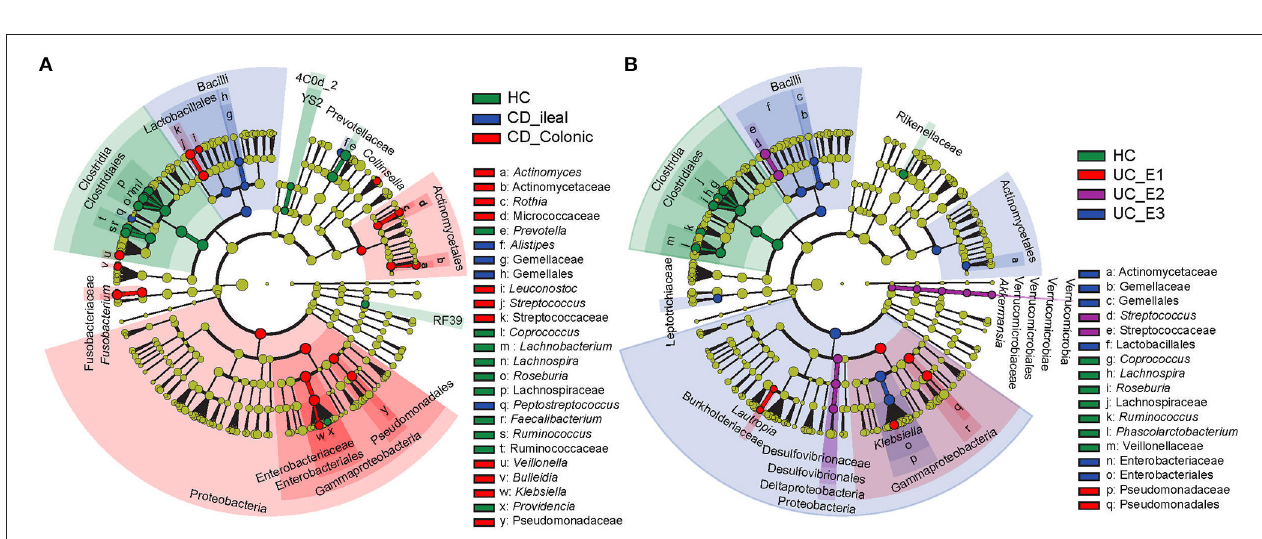
FIGURE 3 | Discriminative taxa determined by LEfSe between healthy controls (HC) and IBD groups. (A) Taxa listed according to LDA values, including LDA value of each significantly discriminative taxon. (B) Cladogram showed discriminative patterns in taxonomic lineages. LDA cutoff was set to 3.5.